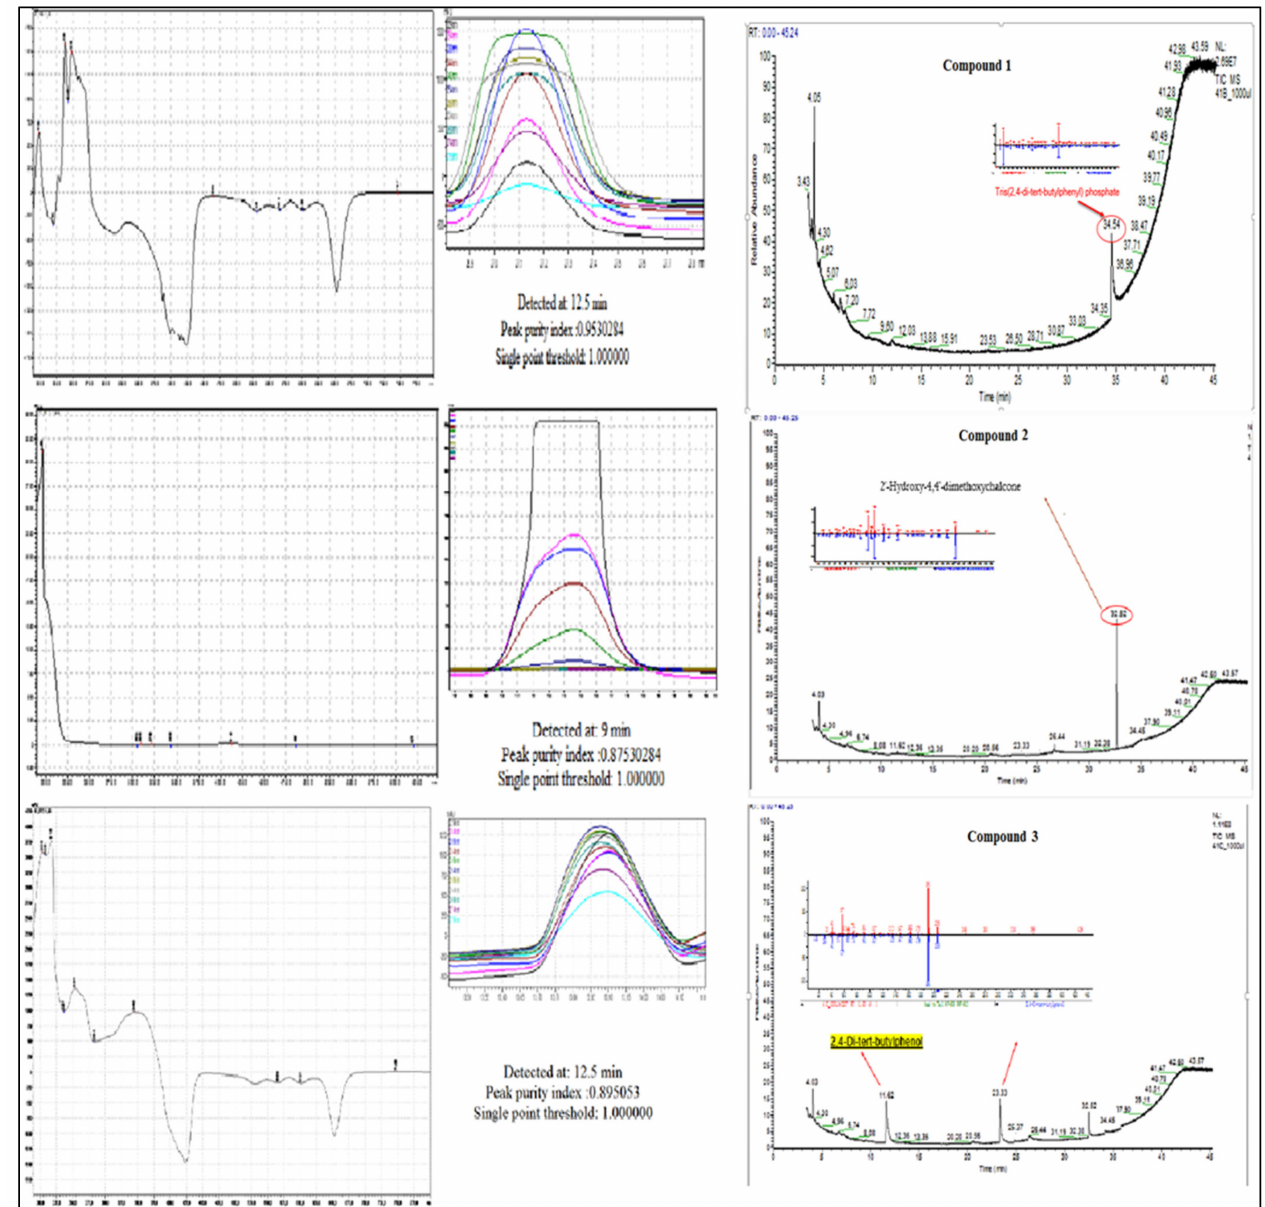
Figure 9. UV–vis apex absorption spectra and mass spectra of Compound 1 Tris (2,4-di- tert - butylphenyl), 2 (4-Hydroxy-2,4 (cid:48) -dimethoxychalcone), and 3 (2,4-di- tert -butylphenol). Compound 2 is identified to be 4-Hydroxy-2,4 (cid:48) -dimethoxychalcone (Figures 8–10). The compound is 4-Hydroxy-2,4 (cid:48) -dimethoxychalcone (C 17 H 16 O 4 ) belongs to the class of organic compounds known as chalcones. They are one of the leading classes of flavonoids throughout the entire kingdom of plants. Chalcones are reported to have clinical applica- tions in humans. Previously Licochalcones isolated from licorice has been listed to have an array of biological activities